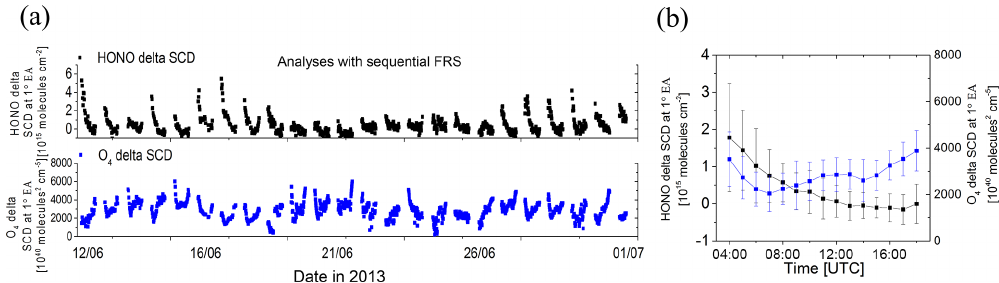
Figure 2. (a) The hourly averaged HONO and O 4 delta SCDs for 1 ◦ elevation angle (using a sequential FRS) derived from the measurements of the AIOFM instrument during the whole comparison period. (b) For the same data, the averaged diurnal variations and the respective standard deviations (error bars) in each hour are given.